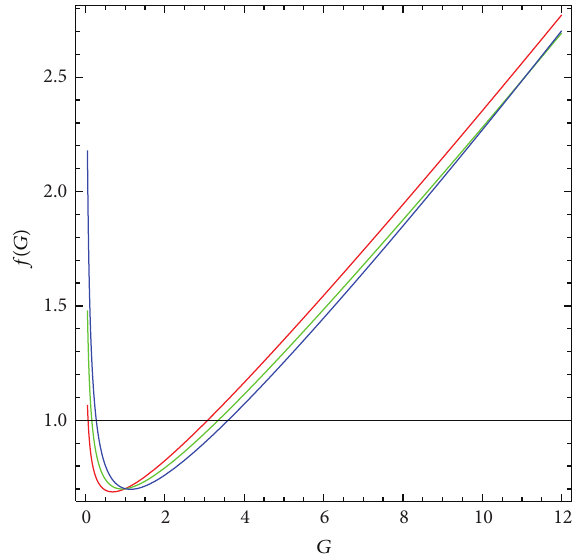
Figure 3: Plot of 𝑤 versus 𝑧 for PDE parameter 𝑢 = 2 with 𝑚 = 2 PDE (red), 𝑚 = 2.2 (green), and 𝑚 = 2.4 (blue).